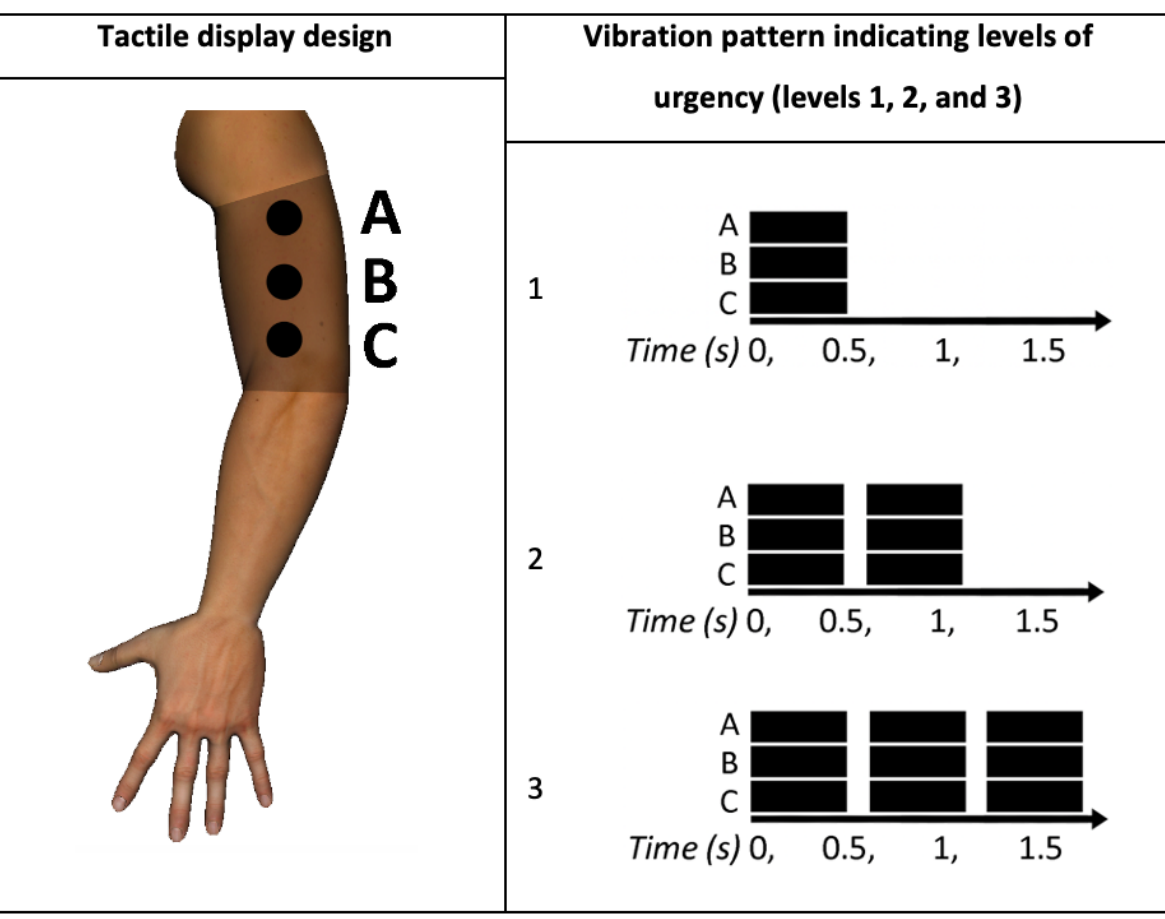
Figure 13. An elasticized sleeve on the upper arm holding 3 tactors (A, B, and C). Three vibration patterns indicated 3 levels of urgency, with the pattern repeating itself after a 800 milliseconds pause (a model of the concept presented in the paper by Cobus and Heuten